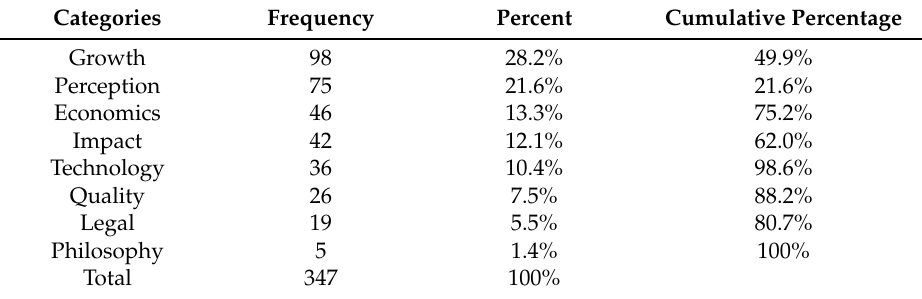
Table 4. Frequency and percentage distribution of articles about OA between